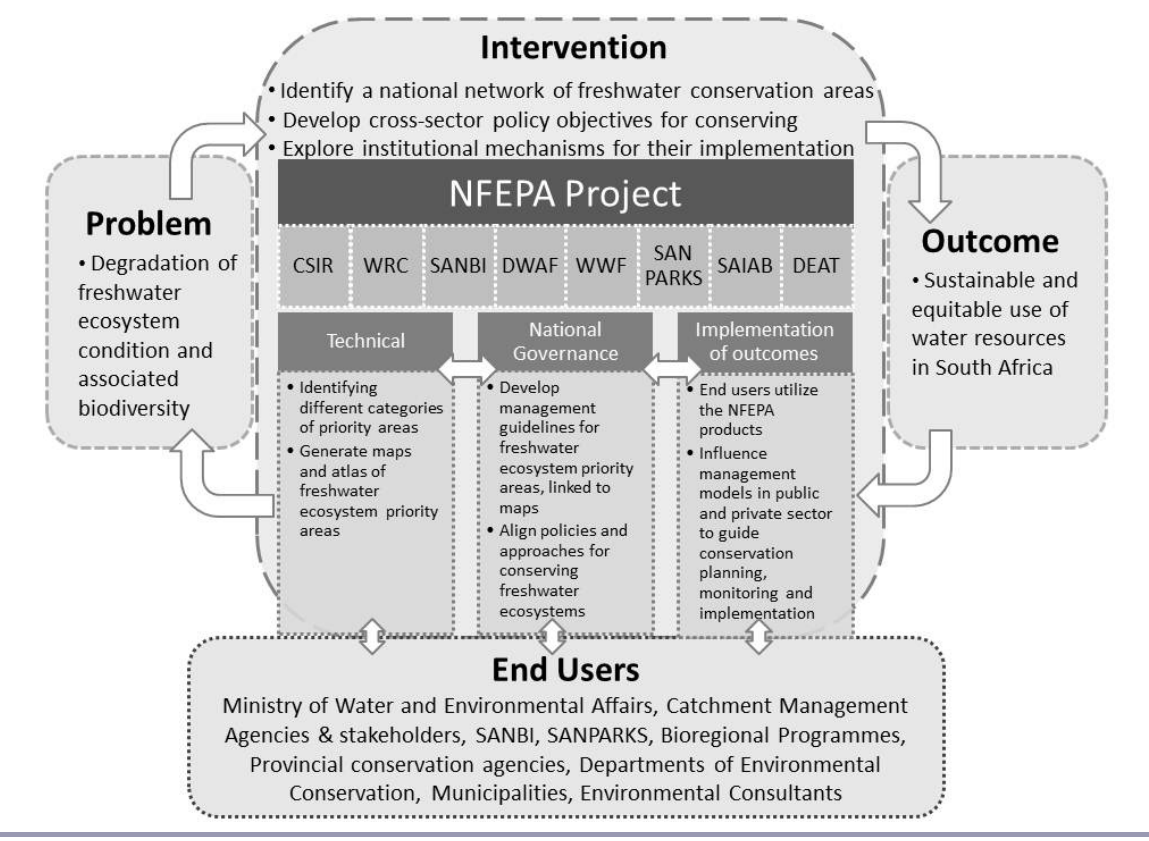
Fig. 1 . A conceptual diagram showing the aim of the NFEPA project, the project team, and the different components of the